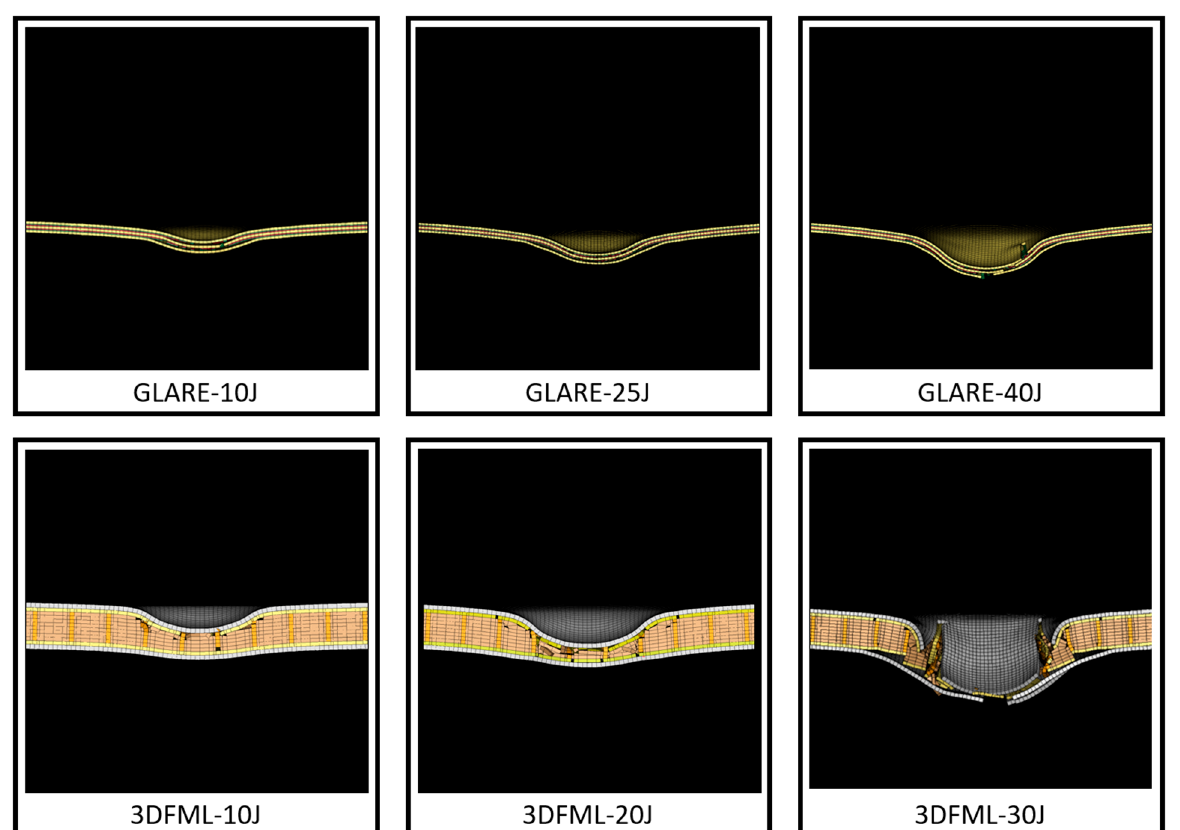
Figure 12. Numerical results that correspond to the locations that were micro-CT scanned.